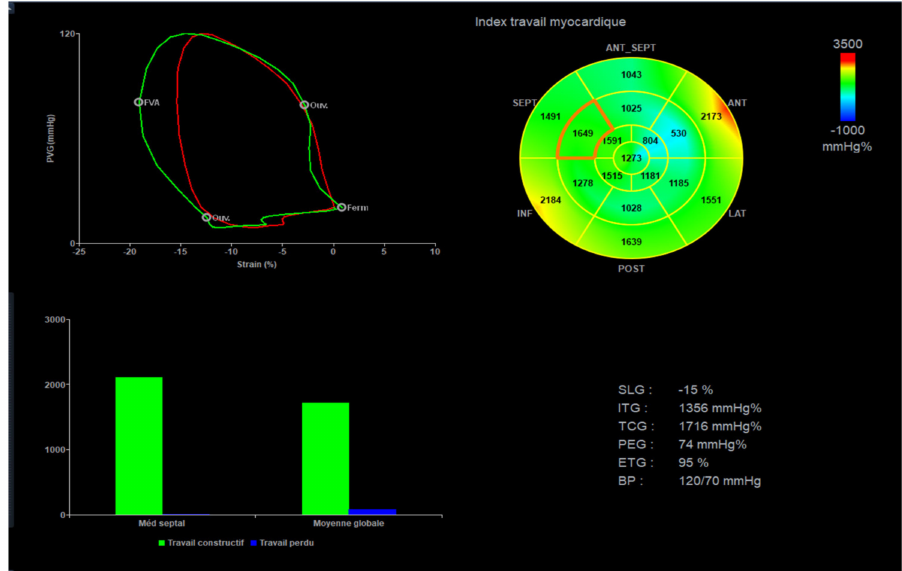
Figure 8. Myocardial work calculation: GWI = 1356 mmHg%, GCW = 1716 mmHg%, GWW = 74 mmHg%, Global work efficiency (GWE) =